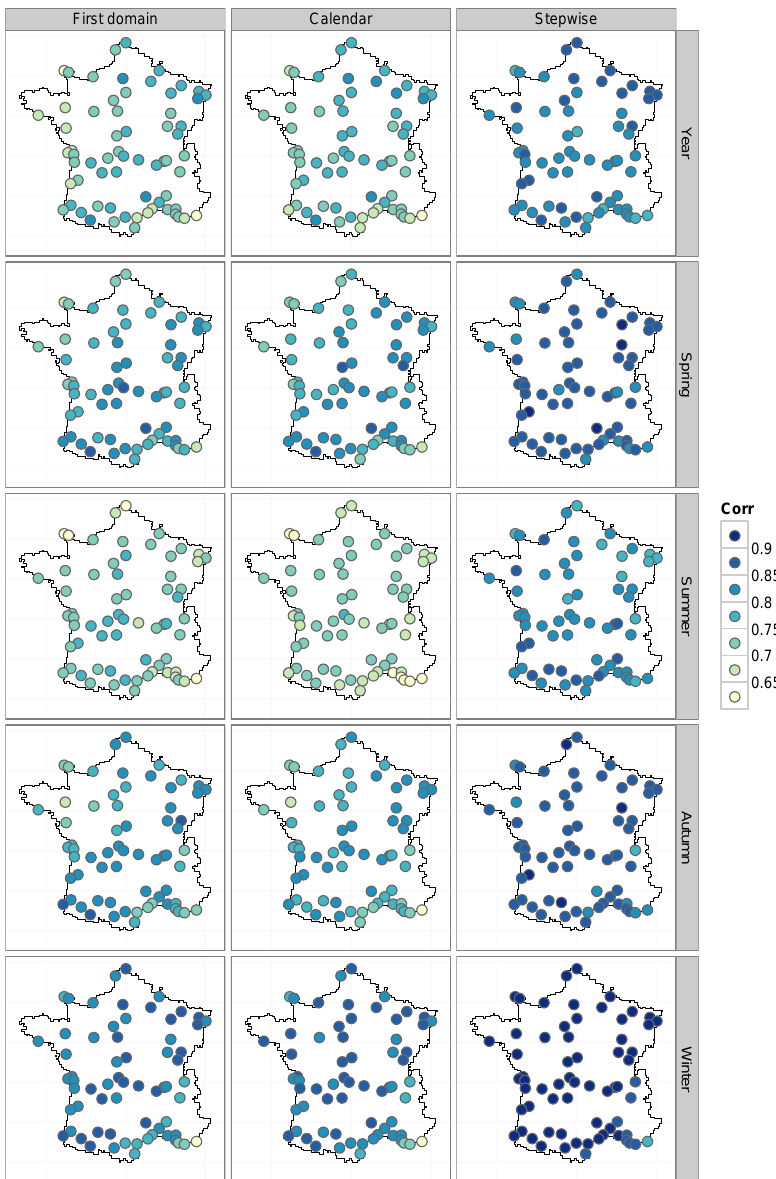
Figure 11. Median of the annual and seasonal temperature rank correlation between homogenized series and all three subselection methods for the 1900–2000 period. Minimum correlation of 0.58 for the first domain selection in winter and maximum correlation of 0.95 for the stepwise selection in